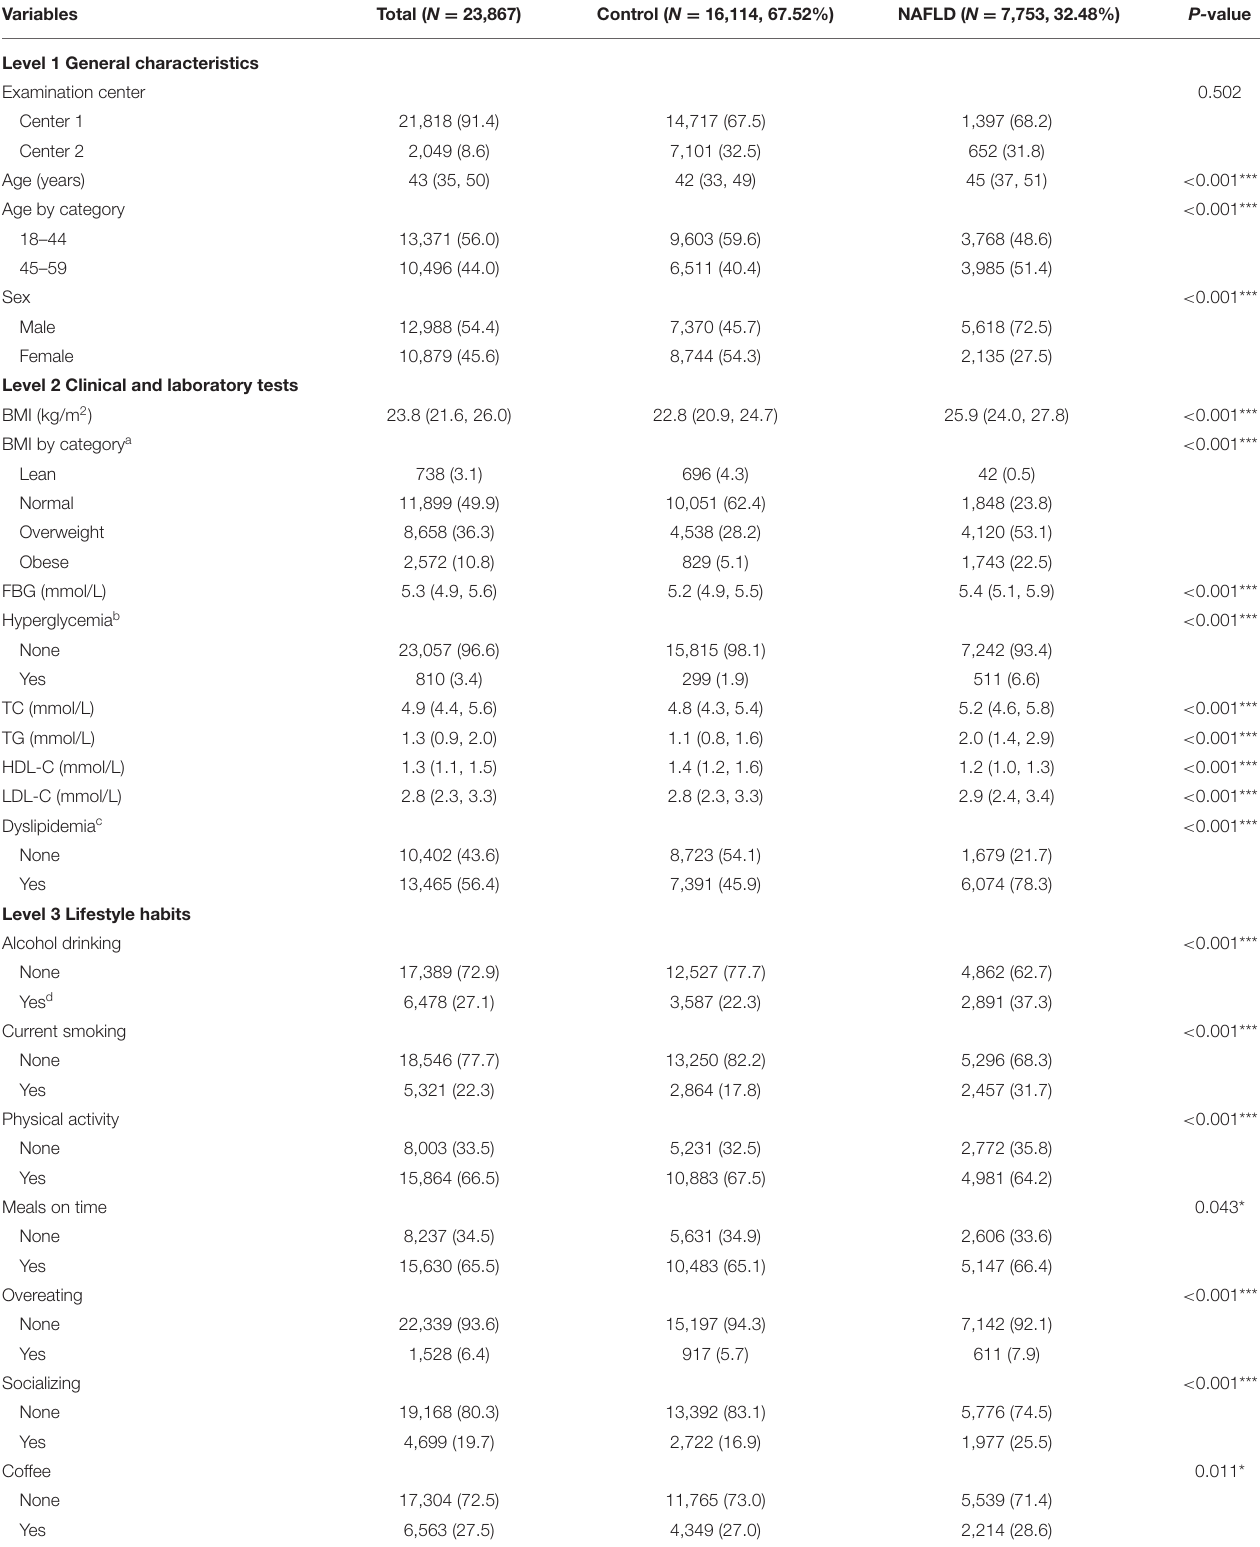
TABLE 1 | Basic characteristics of study participants stratified by NAFLD.